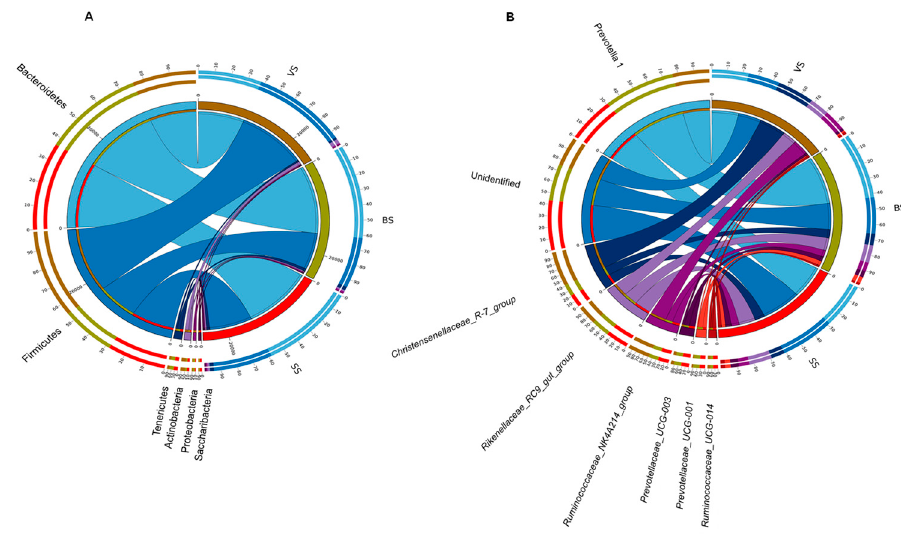
Figure 3. Bacterial phyla ( A ) and genus ( B ) (relative abundance >0.1% in at least 60% of the yaks within each phenological period) of 3 the phenological periods visualized using Circos. VS: Vegetative stage, BS: Bloom stage, SS: Senescent stage.